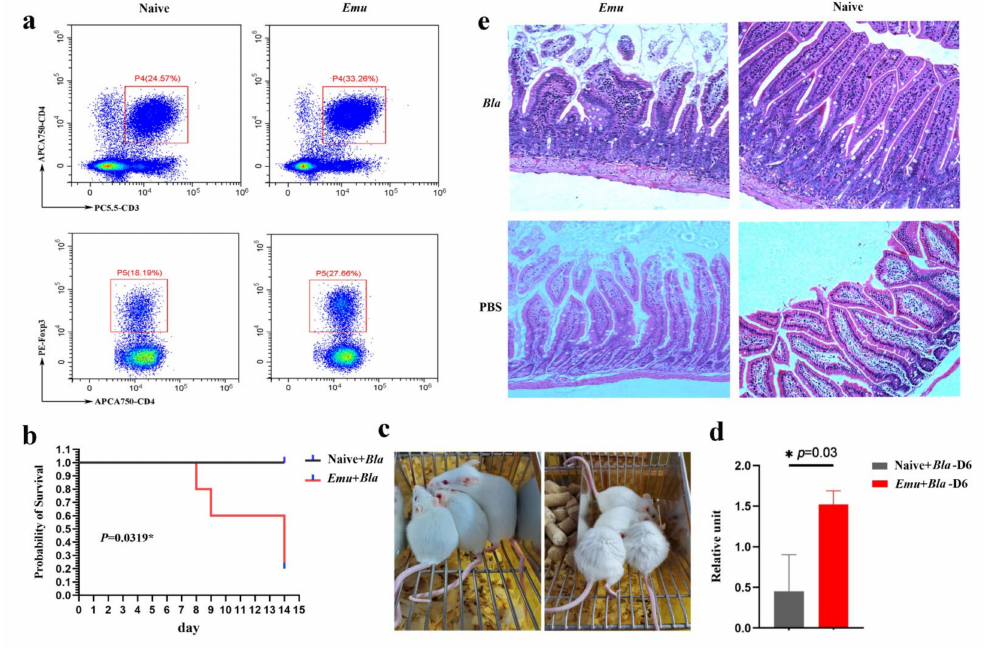
Figure 2. E. multilocularis ( Emu ) infection increased the susceptibility to Blastocystis ( Bla ) in a mouse model. ( a ) Flow cytometry analysis revealed that regulatory T cells (Treg) were expanded in the Balb/c mice that were pre-infected with E. multilocularis 3 months ago. ( b ) The survival rate of mice with dual infection ( E. multilocularis and Blastocystis ) and single infection ( Blastocystis ). ( c ) Symptoms of mice with a single infection (left) and with dual infection (right). The piloerection and torpidity were observed in mice with dual infection (right) but not in the mice with a single infection (left). ( d ) qPCR detection of Blastocystis in feces of the mice at day 6 post-infection. ( e ) H&E staining of jejunum in for the naive mice, and the mice with single ( E. multilocularis or Blastocystis ) or dual infection ( E. multilocularis and Blastocystis ). The * represents the difference was statistically